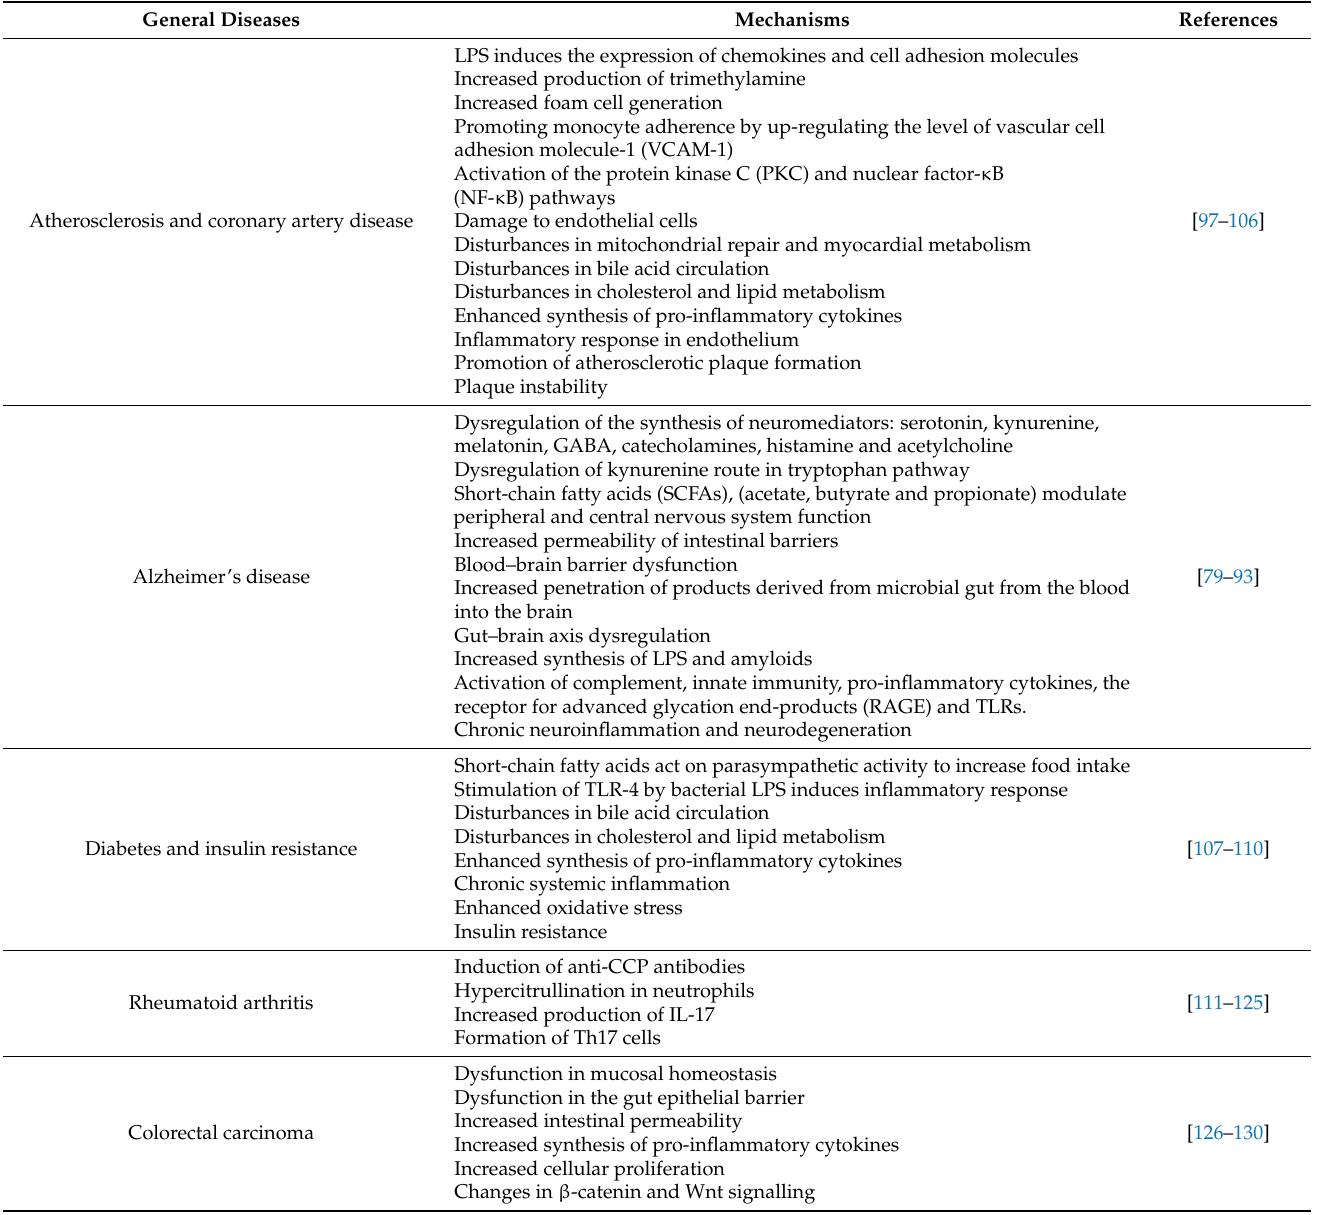
Table 2. The involvement of oral microbiome dysbiosis in the development of